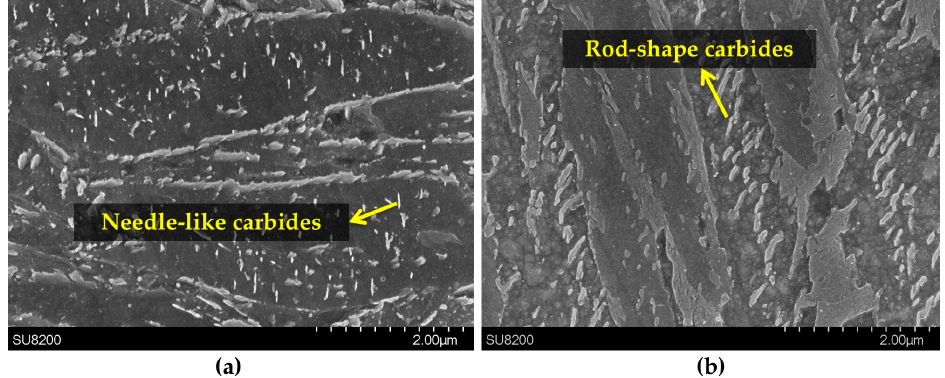
Figure 11. SEM images after non-isothermal tempering at heating rate of 30 °C/min: ( a ) Plates of tempered martensite with fine needle-like carbides within the plate and ( b ) tempered bainite with coarser rod-shape carbides.